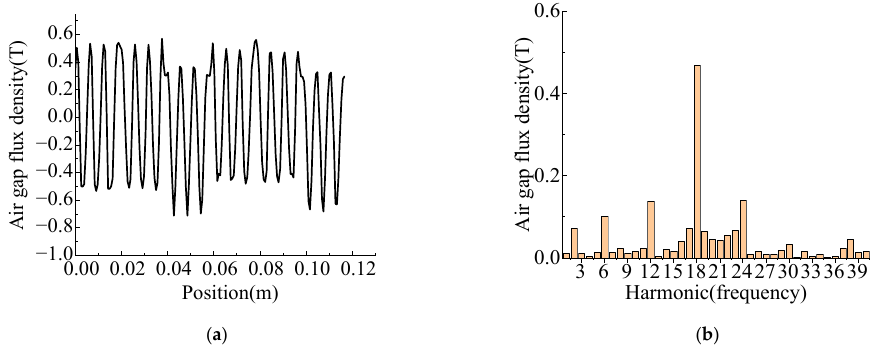
Figure 2. Analysis of air gap flux density and harmonic generated by permanent magnet array: ( a ) Air gap magnetic density ( b ) Harmonic content in air gap.